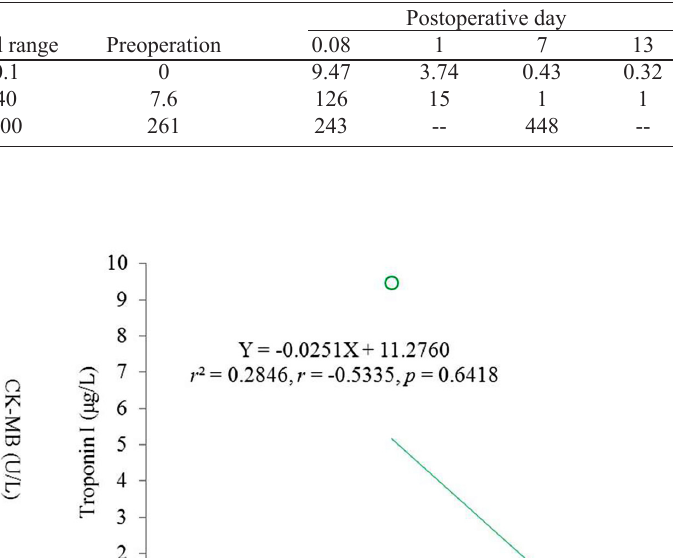
Table 1. Determinations of serum cardiac biomarkers.